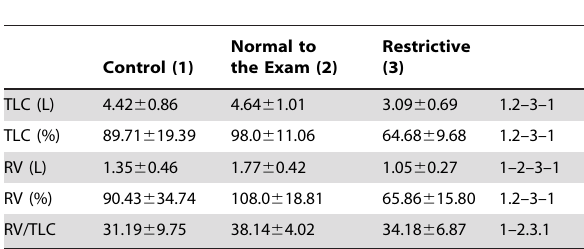
Table 3. Pulmonary volumes obtained in the groups classified using these parameters as a